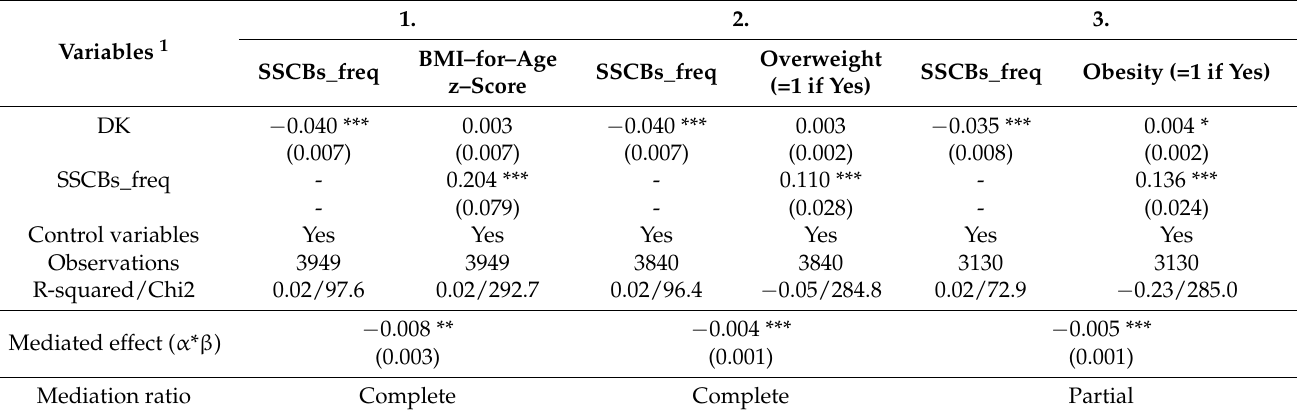
Table 5. Mediation analysis based on standardized regression weights from simultaneous equation modeling with SS- CBs_freq as a mediator (for the entire